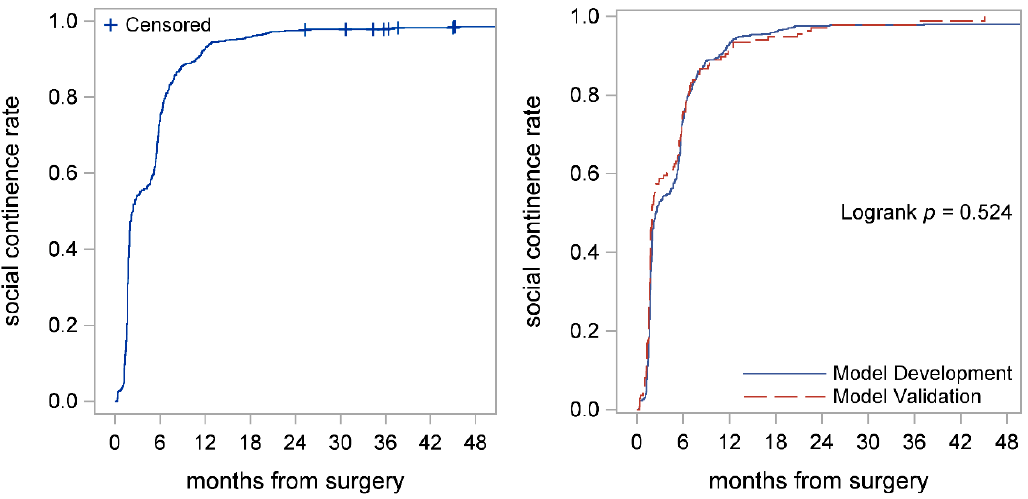
Figure 3. Kaplan–Meier curves showed time to social continence for the entire cohort ( left panel ) and time to social continence in model development and validation cohorts ( right panel ). Median time to social continence was 2.4 (95% CI: 2.0–2.9) months. Social continence rates in model development and validation were similar ( p = 0.524) ( right panel ).